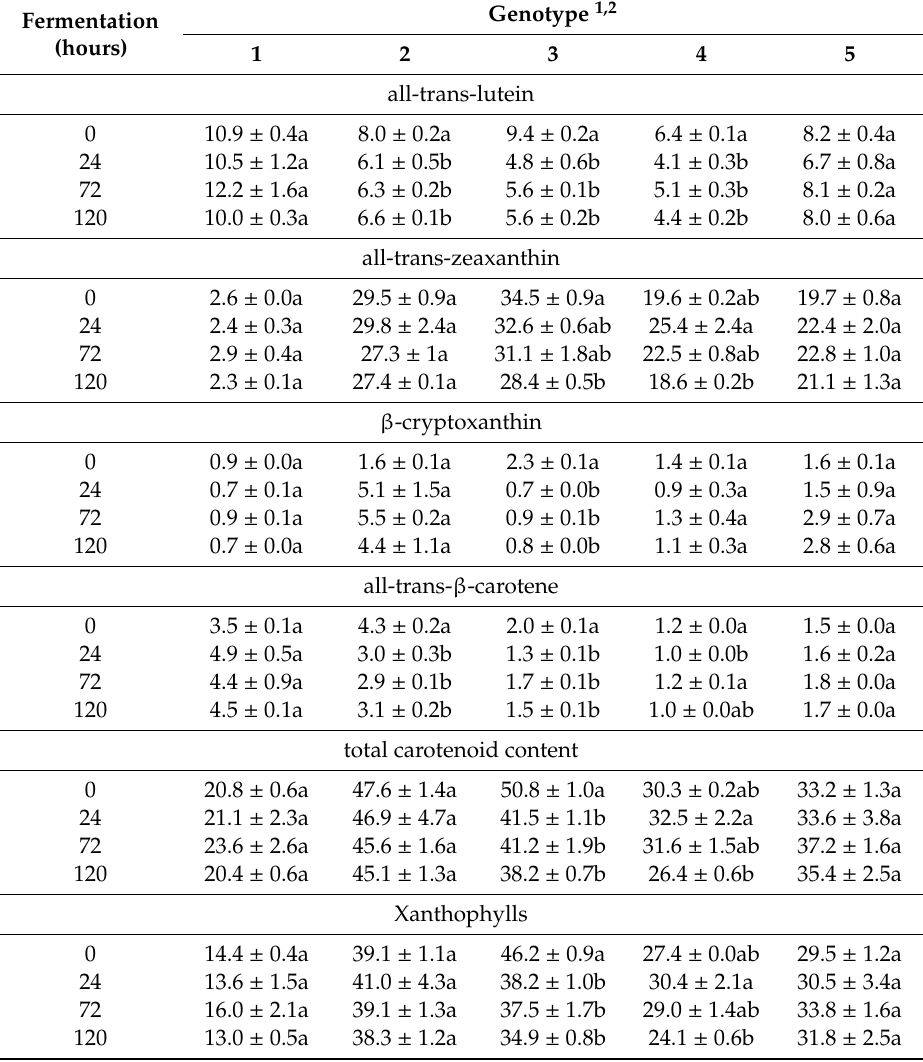
Table 3. Carotenoid contents ( µ g / g DW) of non-fermented and fermented products after